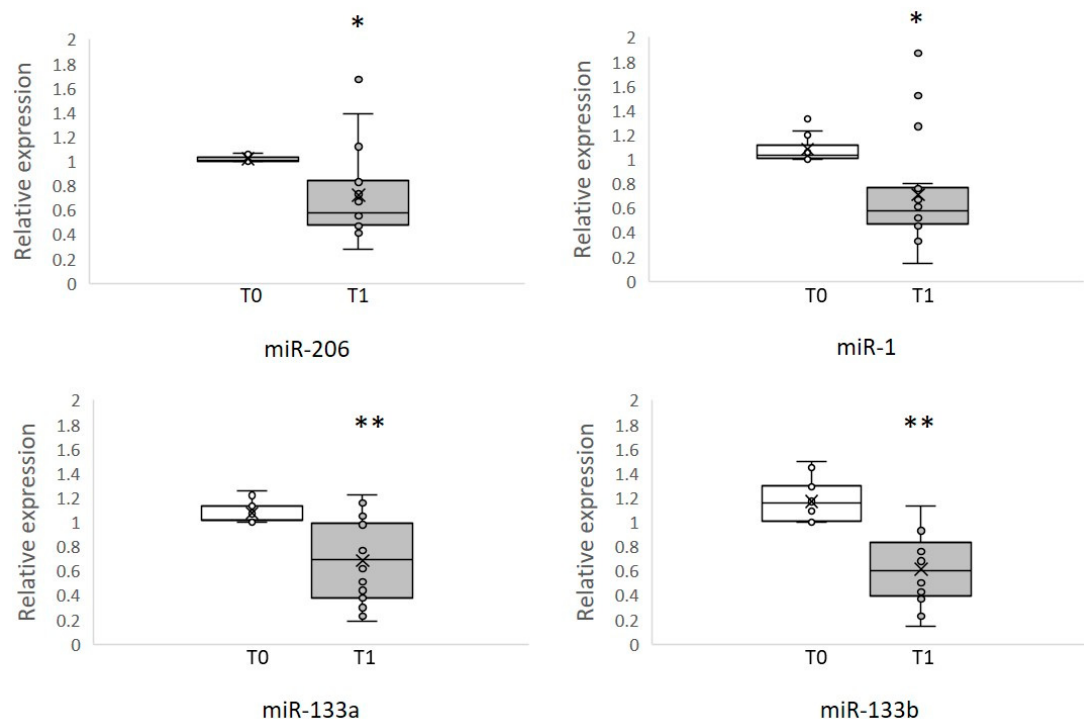
Figure 1. Differential levels of circulating myomiRs in eighteen ALS patients following 6 weeks of physical rehabilitation. The graphs show the levels of miR-206, miR-1, miR-133a, and miR-133b in the serum of ALS patients during rehabilitation. We observed significantly lower levels of miR-206 (* p -value < 0.05), miR-1 (* p -value < 0.05), miR-133a (** p -value < 0.001), and miR-133b (** p -value < 0.001) after rehabilitation treatment (T1). The qPCR data are presented as a relative expression from the pre-training level (T0), where <1 equals a reduction in miRNAs levels. A decreasing trend of miRNAs was observed after rehabilitation training, suggesting a modulation of myomiRs with training. In the box plot, the line that divides the box into two equal parts is the median. Half the scores are greater than or equal to this value and half are less. Individual levels of each myomiRs at T0 and T1 are shown with a single point, while the average of the data is represented with an X. Some values overlap and do not appear in the box-plot.